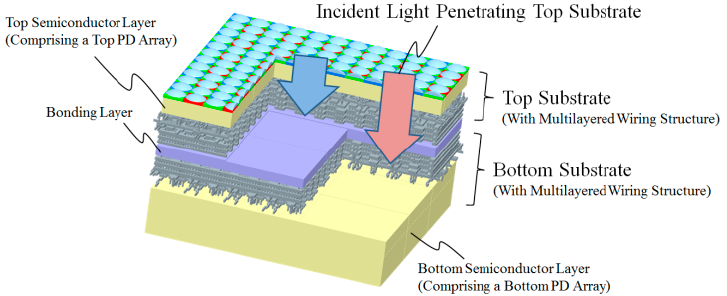
Figure 1. Concept of multi-storied photodiode CMOS image sensor based on 3D silicon stacked technology. The sensor comprises two layers of PD arrays, one in the top and the other in the bottom semiconductor. The top PD array converts a part of incident light into corresponding signals and works as an optical filter for the bottom PD array. The bottom PD array converts light that penetrates through the top substrate into signals, which means the top substrate acts mainly as a visible light sensor and the bottom one is an invisible IR light sensor.